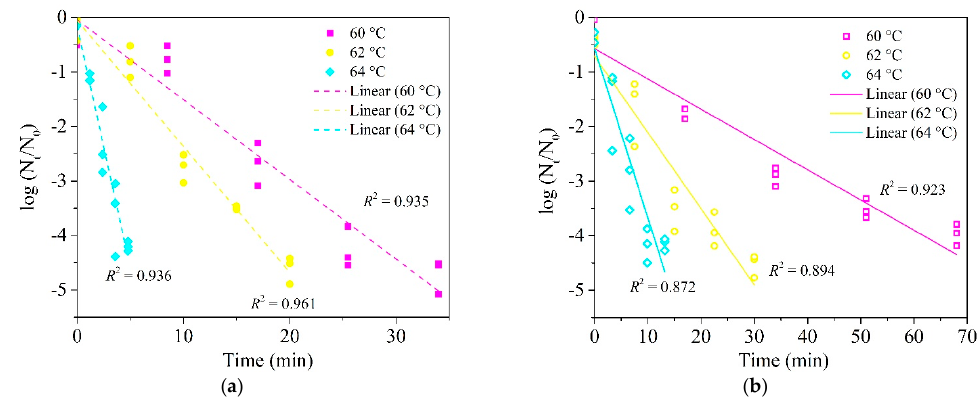
Figure 2. Inactivation kinetic curves of E. faecium in wheat granules (a w = 0.66) ( a ) and flour (a w = 0.65) ( b ) at 75, 80 and 85 °C under a fixed heating rate of 5 °C/min in the HBS. The corrected Figure 3 should be as follows: The corrected Figure 3 should be as follows: